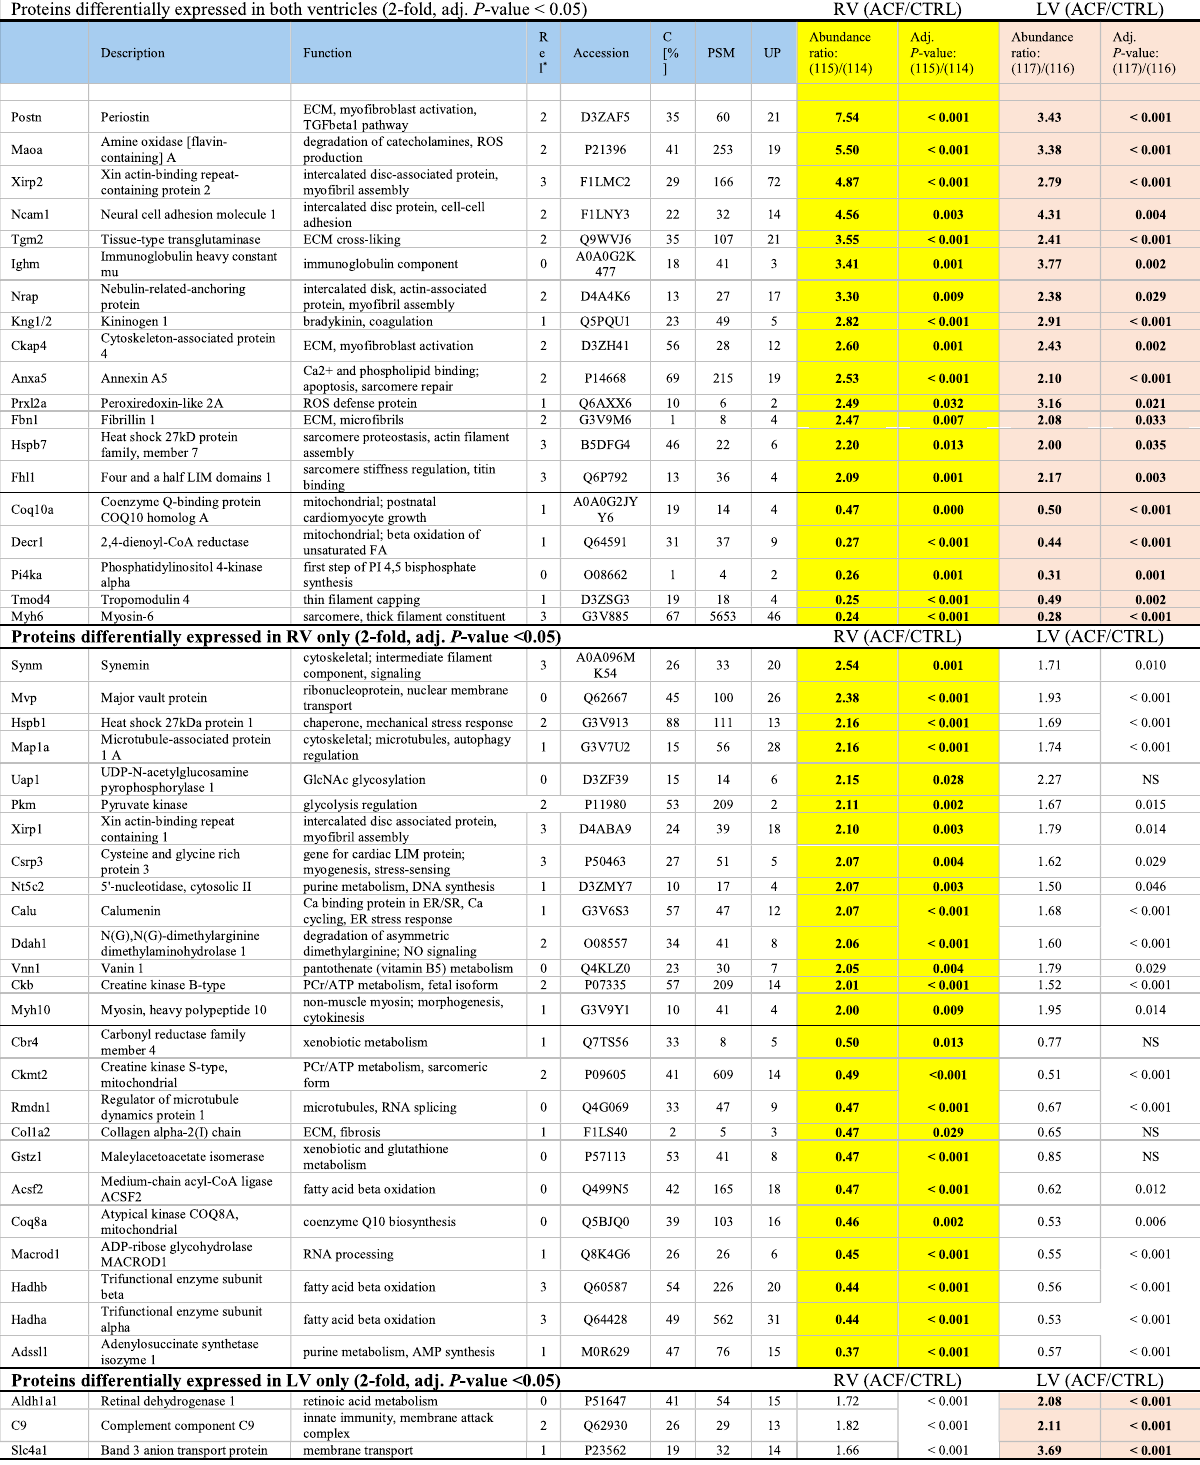
Table 4. Differentially regulated proteins in RV vs LV due to volume overload. Rel*, relevance to known association with myocardium or hearth failure (HF); 0, no reports; 1, known to be in the heart; 2, associates